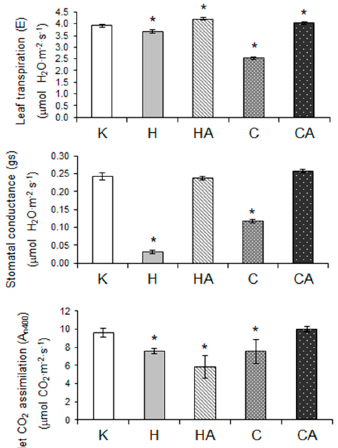
Figure 6. Changes in cauliflower leaf transpiration, stomatal conductance to water vapour and net CO 2 assimilation rate at 400 µmol·m − 2 ·s − 1 illumination in control grown ( K ), cold-stressed ( C ), heat-stressed ( H ), cold-recovered ( CA ) and heat-recovered ( HA ) plants. All parameters were measured on 3-month-old plants with fully developed leaves with the application of an infrared gas analyser. Data were recorded after at least 2 h of illumination. During the experiment, each of the analysed leaves were placed into a 6-cm 2 chamber of the analyser. Results were recorded after initial leaf acclimation to the desired light and CO 2 concentration, relative humidity and temperature. Bars are means ± SD ( n > 3) and asterisks indicate significant differences ( p < 0.05; Student’s t -test) from the control ( K ). Further experimental details in Materials and Methods.